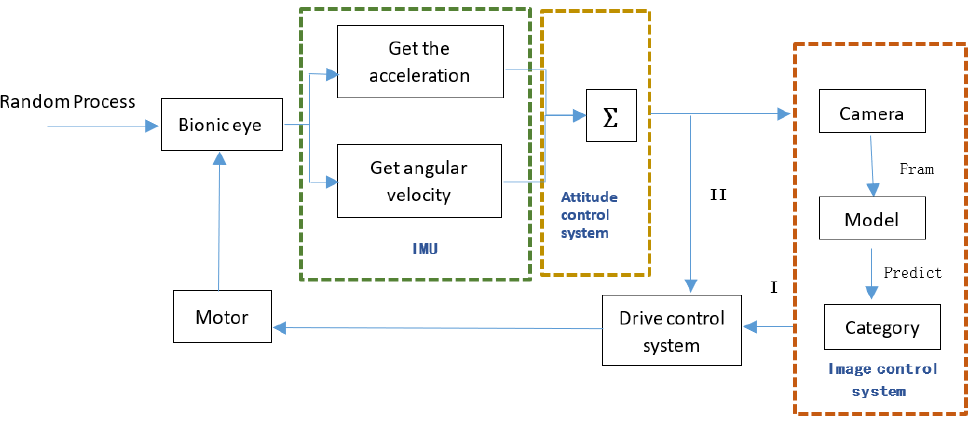
Figure 5. Design scheme of detection system of bionic eye attitude.